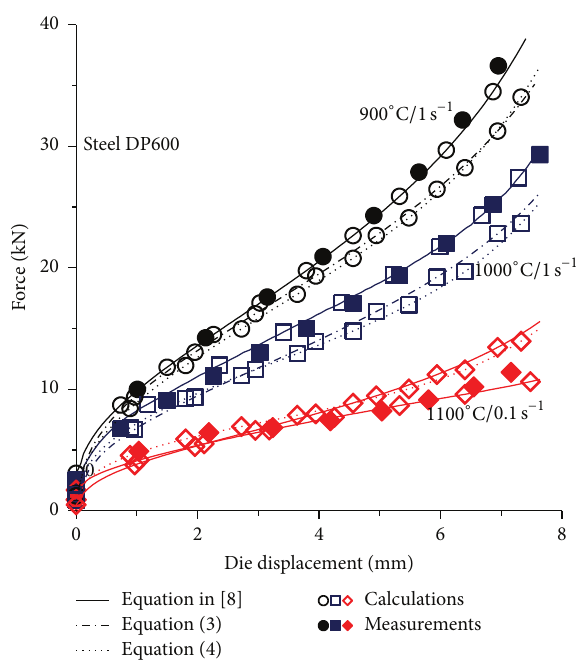
Figure 18: Comparison between loads measured in the tests (filled symbols) and calculated by the FE code with flow stress equations (3) and (4) and equation of [8] with coefficients determined using conventional inverse analysis (open